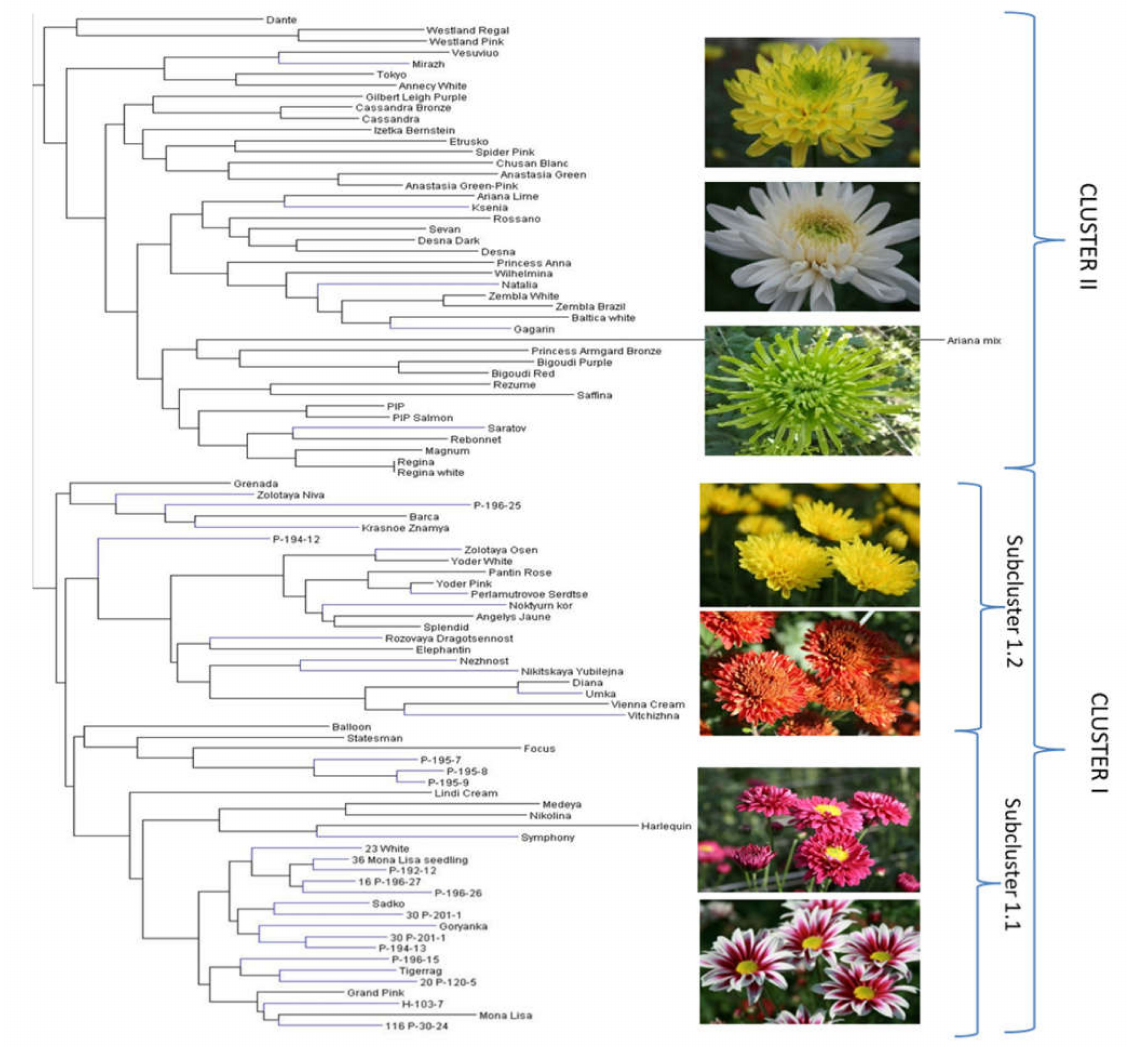
Figure 3. Phenotypic UPGMA–dendrogram of chrysanthemum collection based on 20 important flower traits. Blue branches—genotypes of the Russian breeding, black branches—genotypes of the foreign